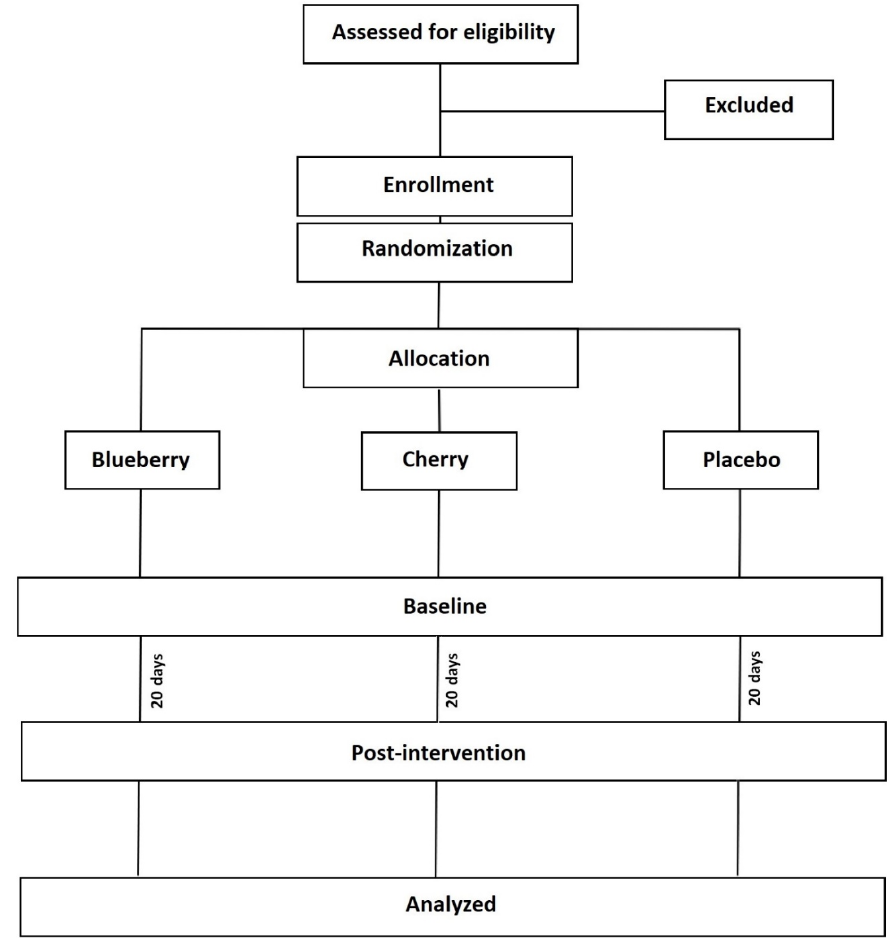
Figure 1. Consort diagram showing the study design.